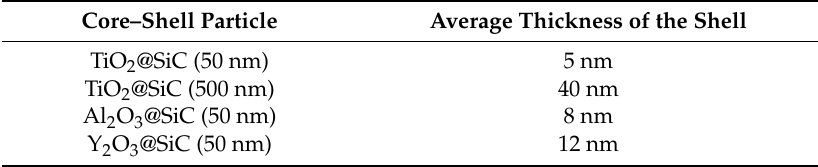
Table 1. Average shell thickness of the M x O m @SiC core–shell nanoparticles (lab synthesis) obtained from the EDX line scans